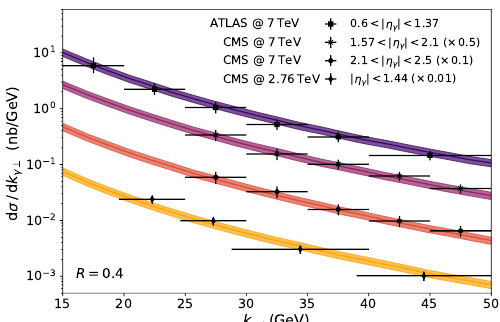
√ s = 2.76,7 TeV [13–15]. The central